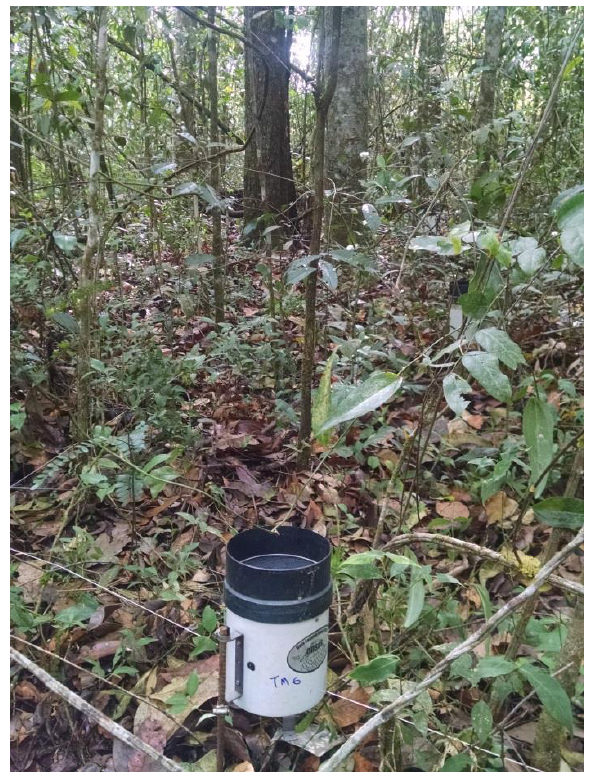
Figure 2. Tipping bucket rain gauge at the experimental plot.